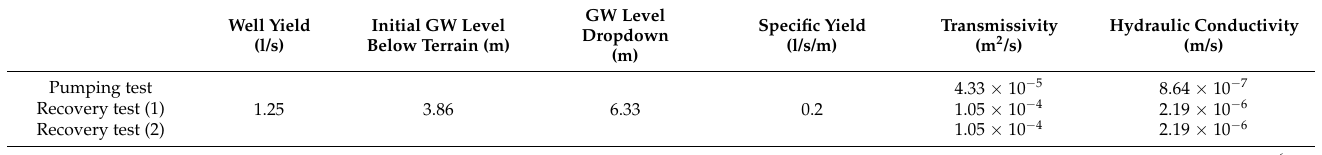
Table 3. Results of pumping and recovery tests for extraction well HJ-4